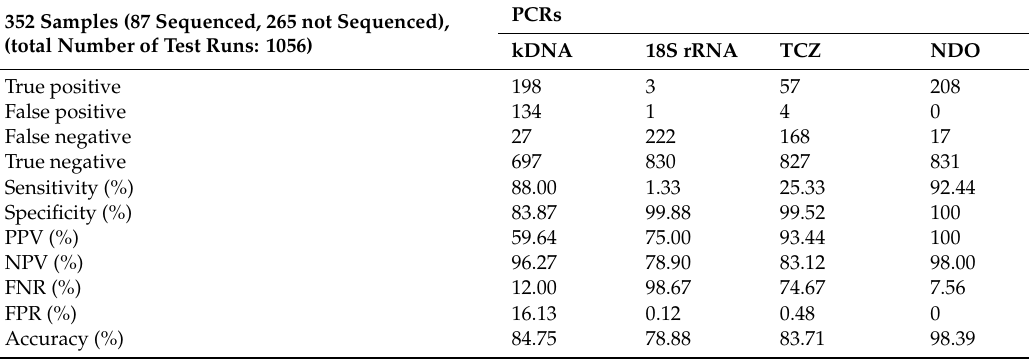
Table 4. Extrapolation, taking the Newly Developed One Real-Time Polymerase Chain Reaction (NDO-RT-PCR) as a gold standard. Positive, if at least one PCR run (triplicate) was positive. PPV: positive predictive value, NPV: negative predictive value, FNR: false negative rate, FPR: false positive rate. NDO-PCR shows best sensitivity and specificities values compared to the other